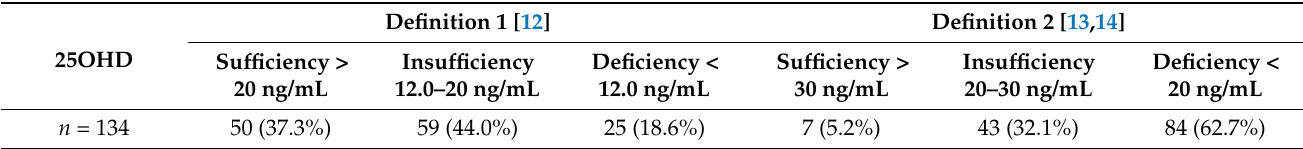
Table 1. Distribution of the study cohort ( n = 134) with regard to vitamin D (25OHD) sta- tus, according to definition 1 [12]: 25OHD sufficiency > 20 ng/mL, insufficiency 12–20 ng/mL, deficiency < 12 ng/mL; or definition 2 [13,14]: 25OHD sufficiency > 30 ng/mL, insufficiency 20–30 ng/mL, deficiency < 20